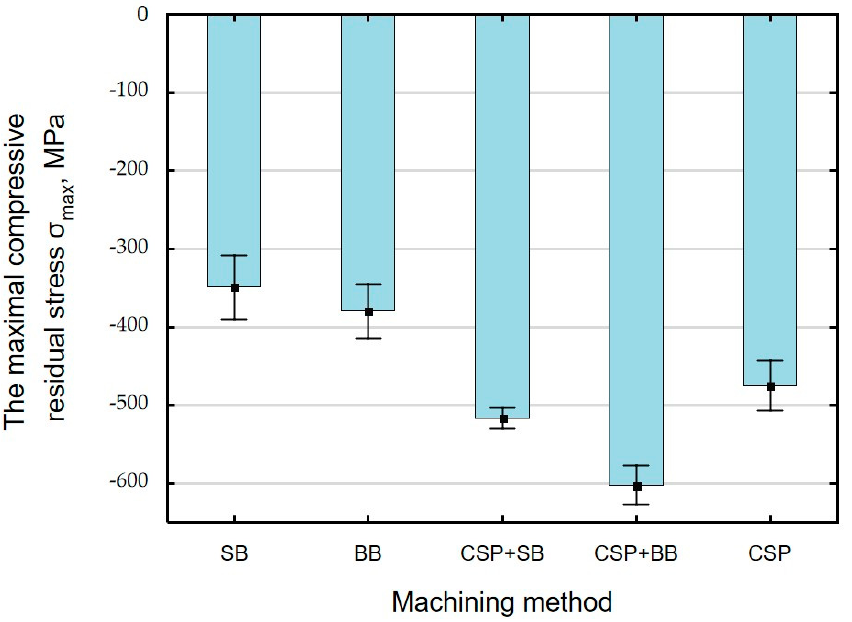
Figure 13. Finishing treatment versus the maximum (absolute value) compressive stresses σ max (SB—slide burnishing, BB—ball burnishing, CSP + SB—centrifugal shot peening + slide burnishing, CSP + BB—centrifugal shot peening + ball burnishing, CSP—centrifugal shot peening).